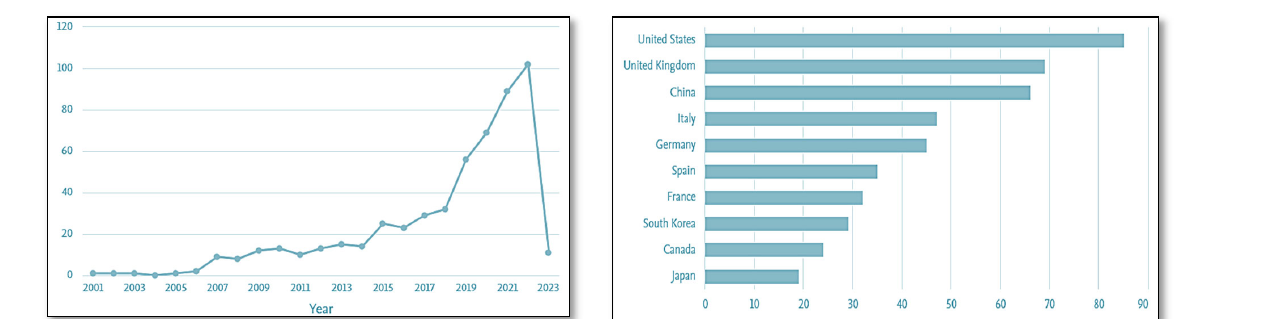
Fig. 1. The growth of the publication based on the variables “Hydrogen”, “fuel” and “production”